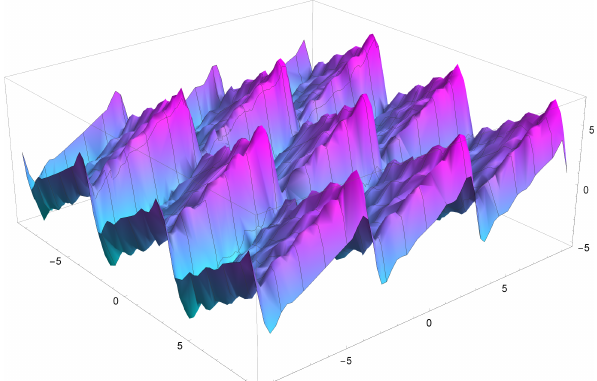
Figure 5 . Expansion of the approximated function in one variable to order N = 4 , M = 4 with a r = b r = 1 and d r = 0 , for a fixed time such that c r τ = 1 . Blue colors represent the lower values of the